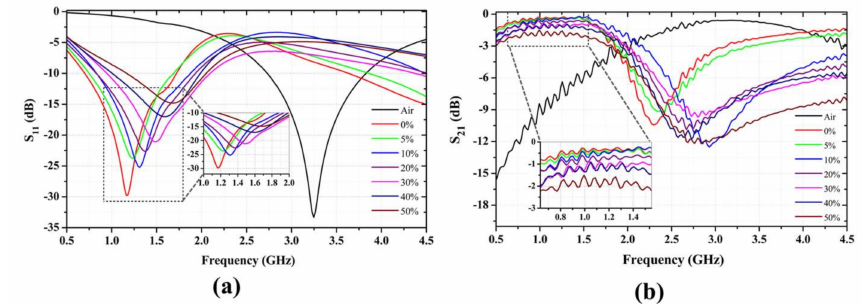
Figure 3. Variation of the peak resonance frequency and the s-parameters ( a ) reflection coefficient (S 11 ) and ( b ) transmission coefficient (S 21 ) in response to the introduction of various concentrations of the water-ethanol solution.